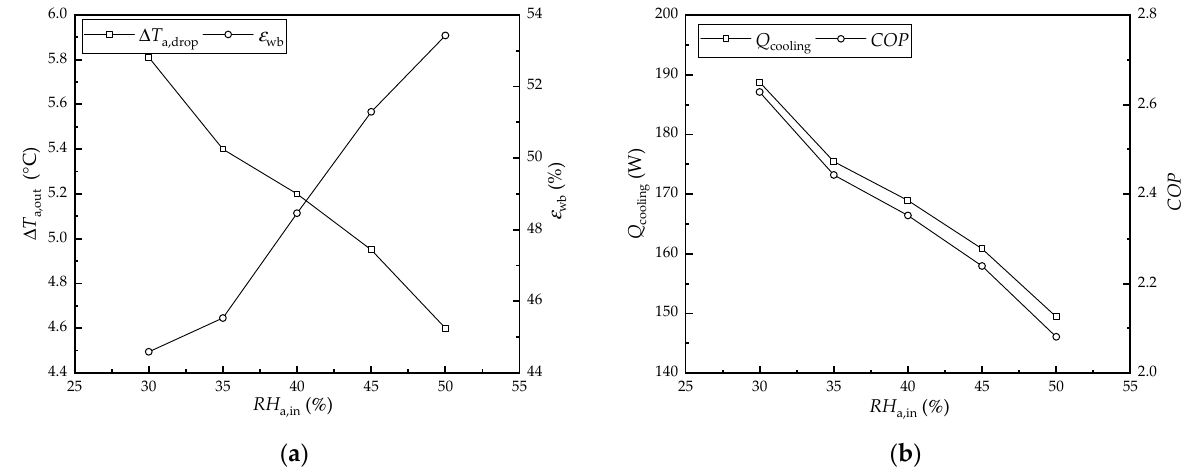
Figure 4. The effect of the inlet air relative humidity on the performance of the HFMEC: ( a ) air temperature drop and wet-bulb efficiency; ( b ) cooling capacity and COP .